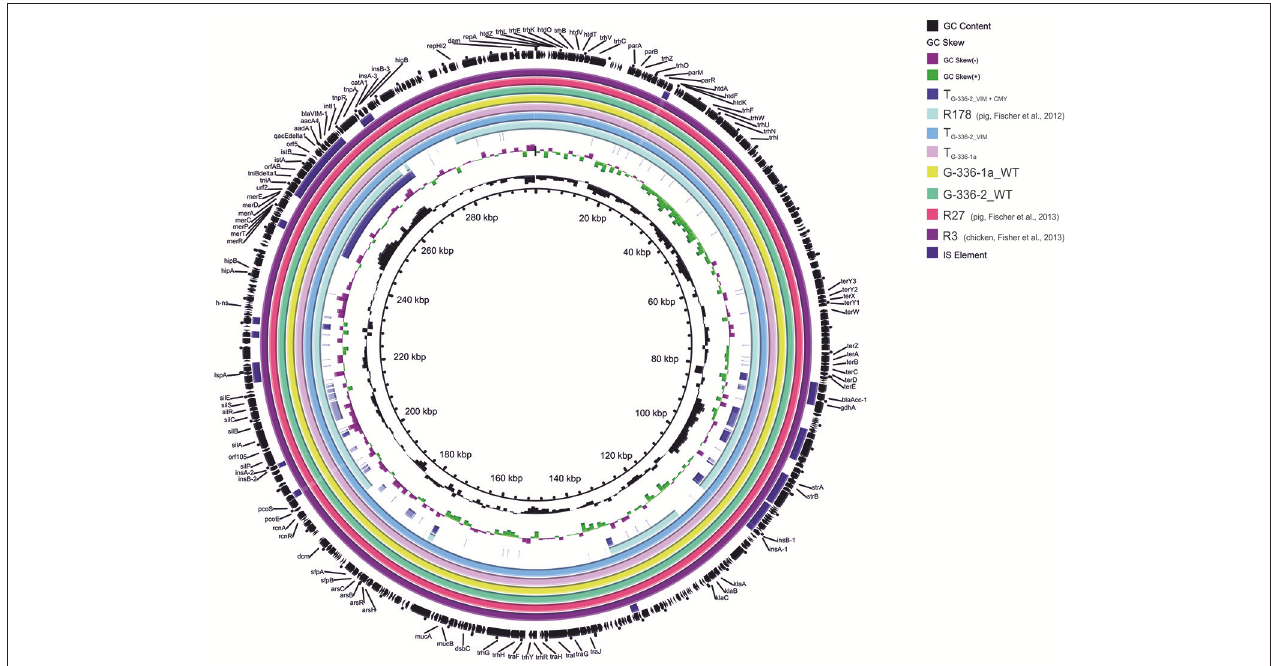
FIGURE 1 | Circular visualization and comparison of bla VIM - 1 -carrying IncHI2 plasmid sequences from S. Infantis as well as E. coli isolates derived from German chicken- as well as pig fattening farms and their transformants using BRIG. WT, wildtype; T, transformed E. coli NEB10 ®